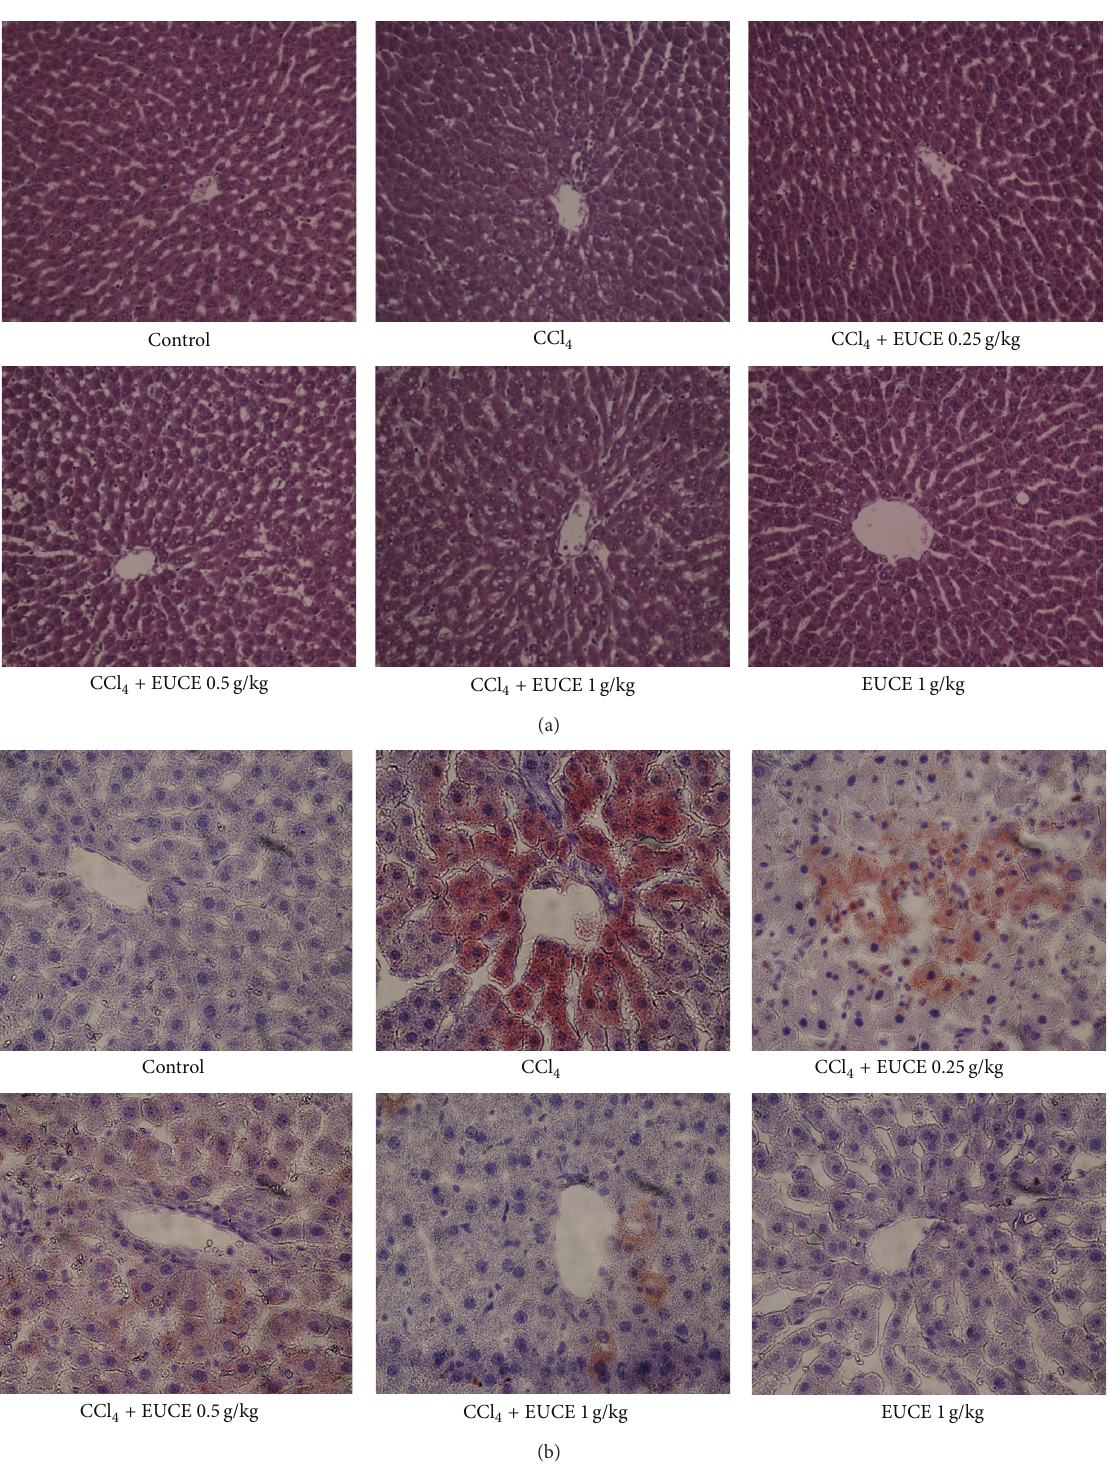
Figure 1: Effect of EUCE on CCl 4 -induced histological changes in liver. Rats were injected with 1mg/kg CCl 4 , and livers were isolated after 4 hours. Representative photomicrographs (200x) of liver sections from rats ( 𝑛 = 8 ) stained with hematoxylin and eosin (a) and oil red O (b) are